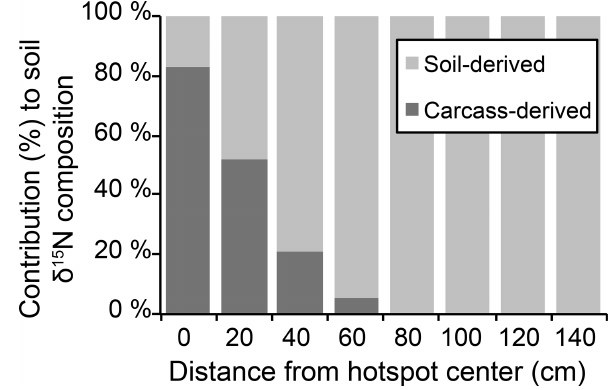
Figure 4. Results of linear two-member isotope mixing distinguish- ing the contributions of soil and carcass fluid to bulk soil stable iso- topic